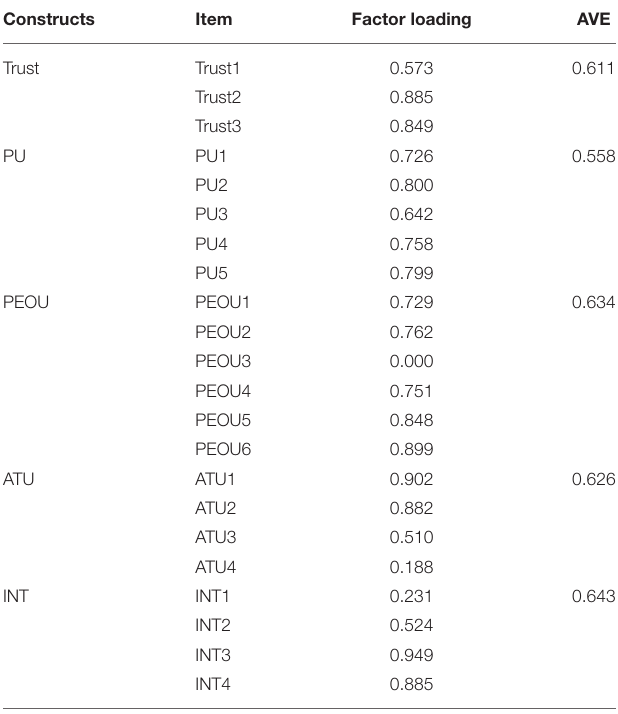
TABLE 4 | Convergent validity analysis results.